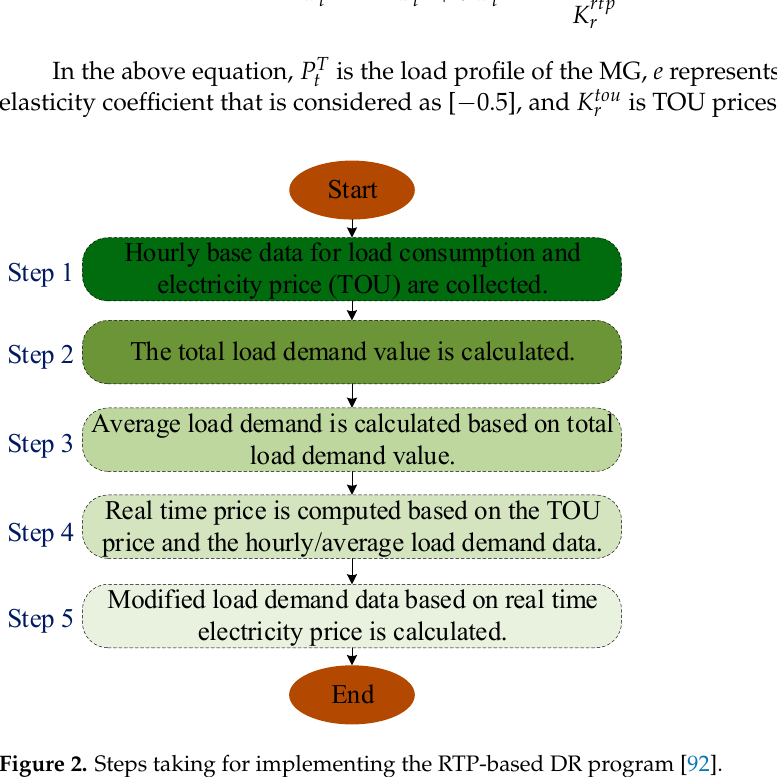
Figure 2. Steps taking for implementing the RTP-based DR program